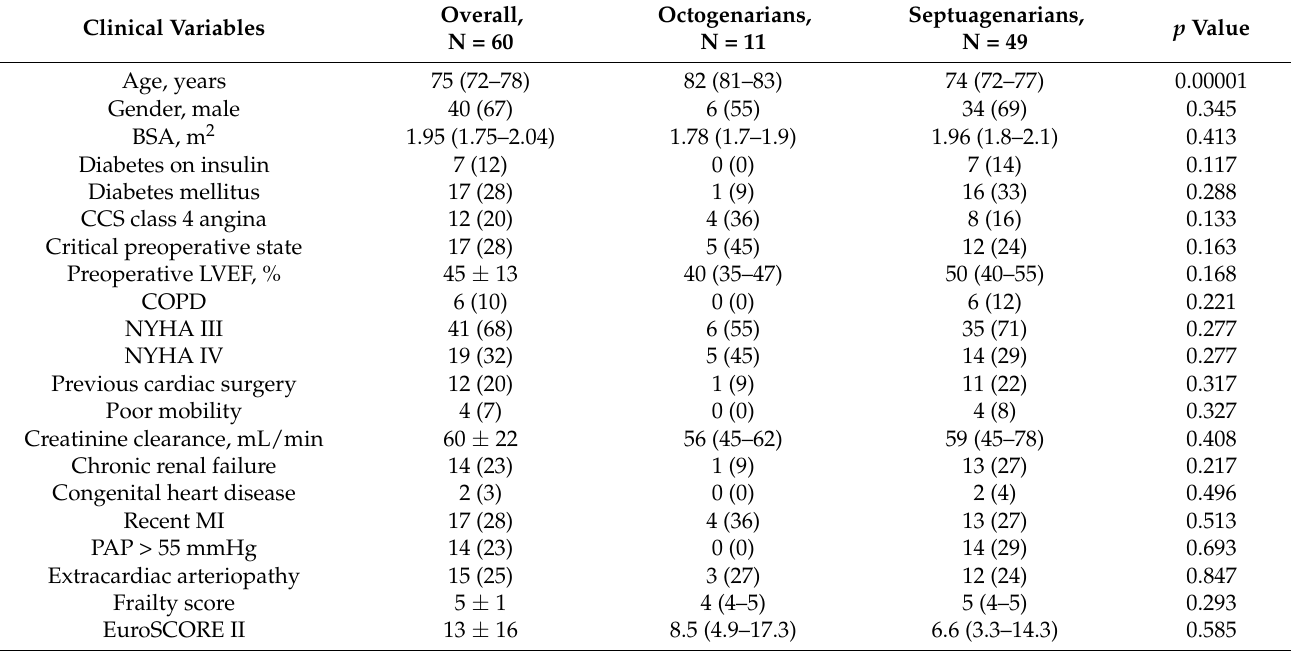
Table 1. Baseline patient’s characteristics and preoperative